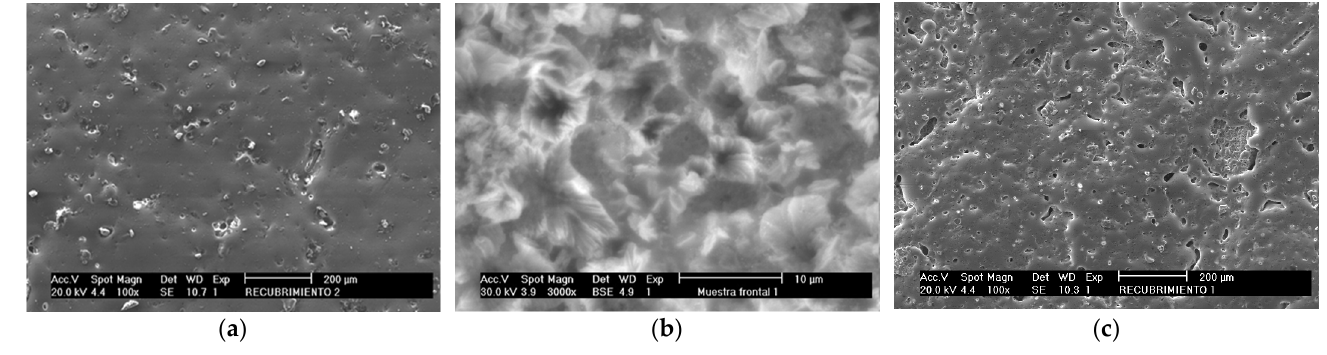
Figure 2 . Microphotographs (SEM) of the protective coating fired at 850 °C ( a , b ) and at 820 °C ( c ). Figure 2. Microphotographs (SEM) of the protective coating fired at 850 ◦ C ( a , b ) and at 820 ◦ C ( c